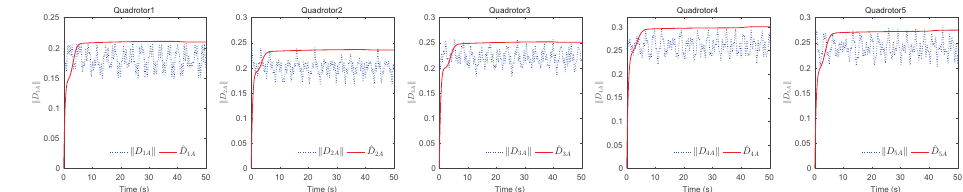
Figure 12. Estimation of external disturbances’ upper bounds.